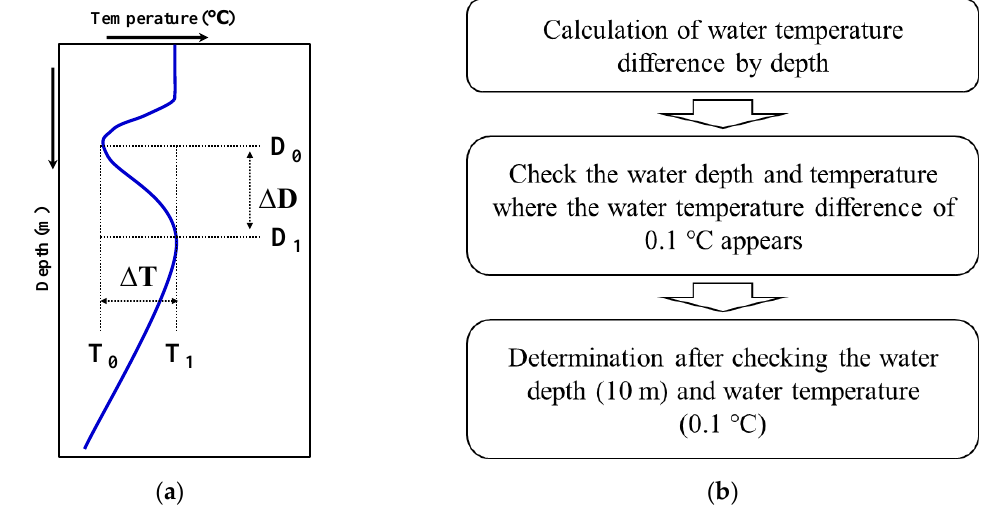
Figure 2. A schematic diagram showing of TIL ( a ). T 0 and D 0 is TIL starting point and T 1 and D 1 is maximum water temperature of a TIL. The flow chart for determination of water temperature inversion layer ( b ).